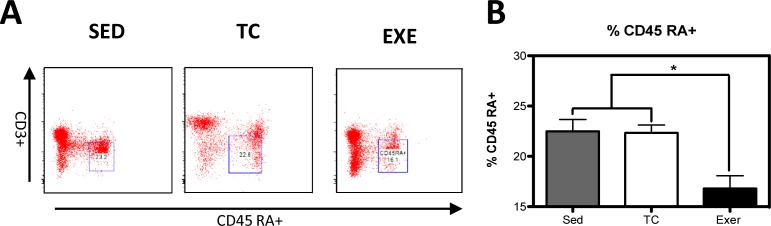
Changes in the composition of B-lymphocytes from spleen.(A) Representative dot plot of the cytometric analysis of the subpopulation percentages. (B) Determination of B-lymphocytes of spleen of rats in the different groups: SED, TC and EXE; data from 4 independent experiments are expressed as mean ± SE. B lymphocytes showed a statistically significant change (ANOVA, p = 0.3601, n = 10). * Means statistically different from the two other groups, P<0.05.